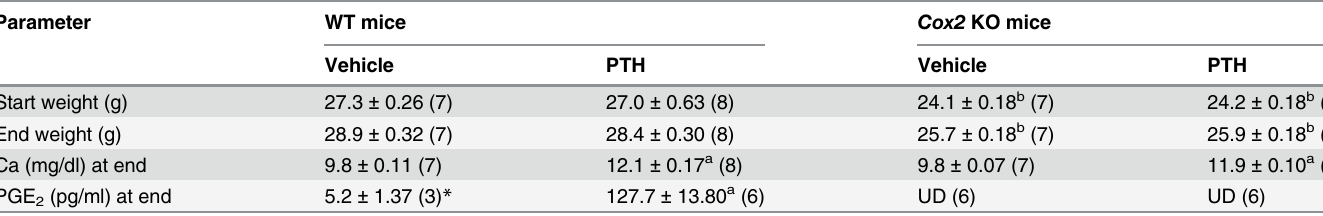
Table 3. Body weight, serum calcium (Ca) and serum PGE 2 in wild type (WT) and Cox2 KO mice infused with vehicle or PTH for 12 days. Parameter